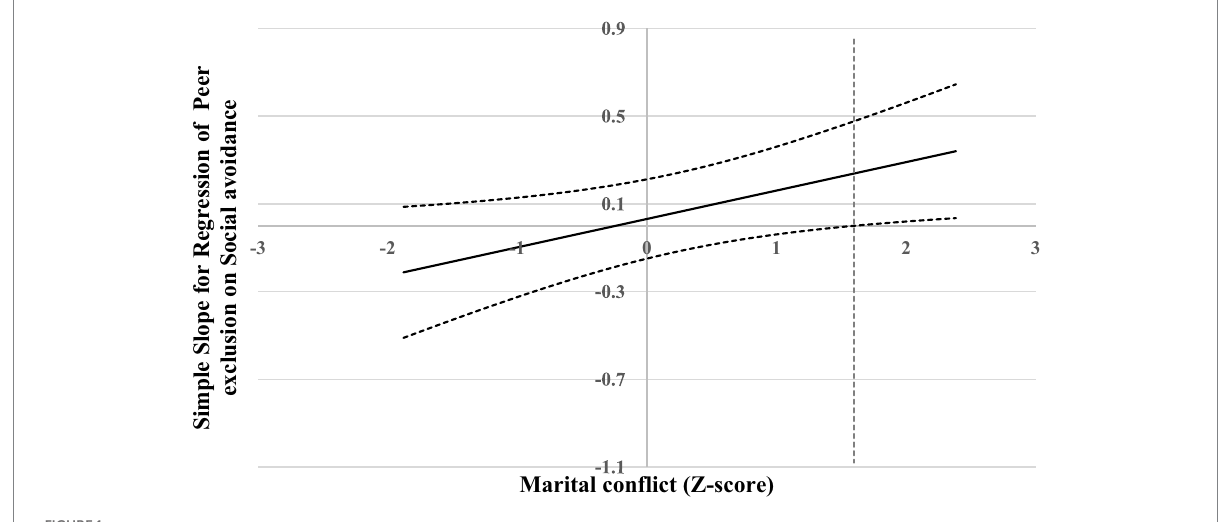
FIGURE 1 Johnson-Neyman regions of significance and confidence bands for social avoidance along marital conflict in relation to peer exclusion. Solid diagonal line represents the regression coefficient for social avoidance along marital conflict. Dashed diagonal lines are confidence bands—upper and lower bounds of 95% confidence interval for social avoidance coefficient along marital conflict. The dashed vertical red line indicates the point along marital conflict at which the social avoidance regression coefficient transitions from non-significance (left of dashed vertical line) to statistical significance (right of dashed vertical line). The value of the dashed vertical line is